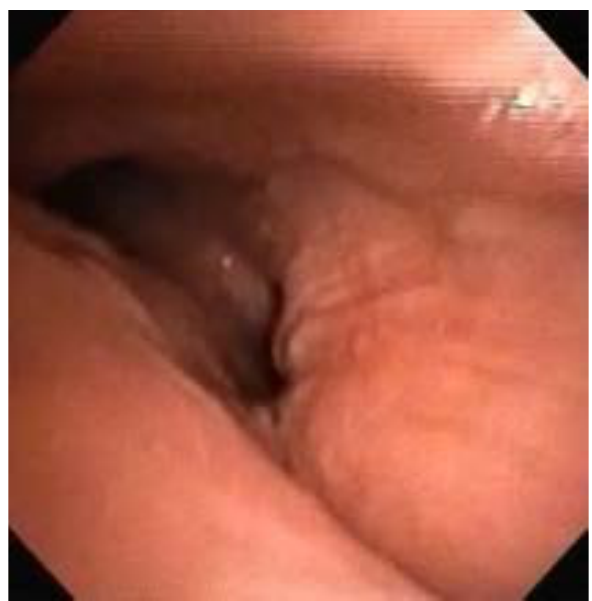
Figure 5. Significant glycosaminoglycan (GAG) infiltration in a MPS II patient (infiltration and architectural distortion of the distal trachea and right main bronchus).